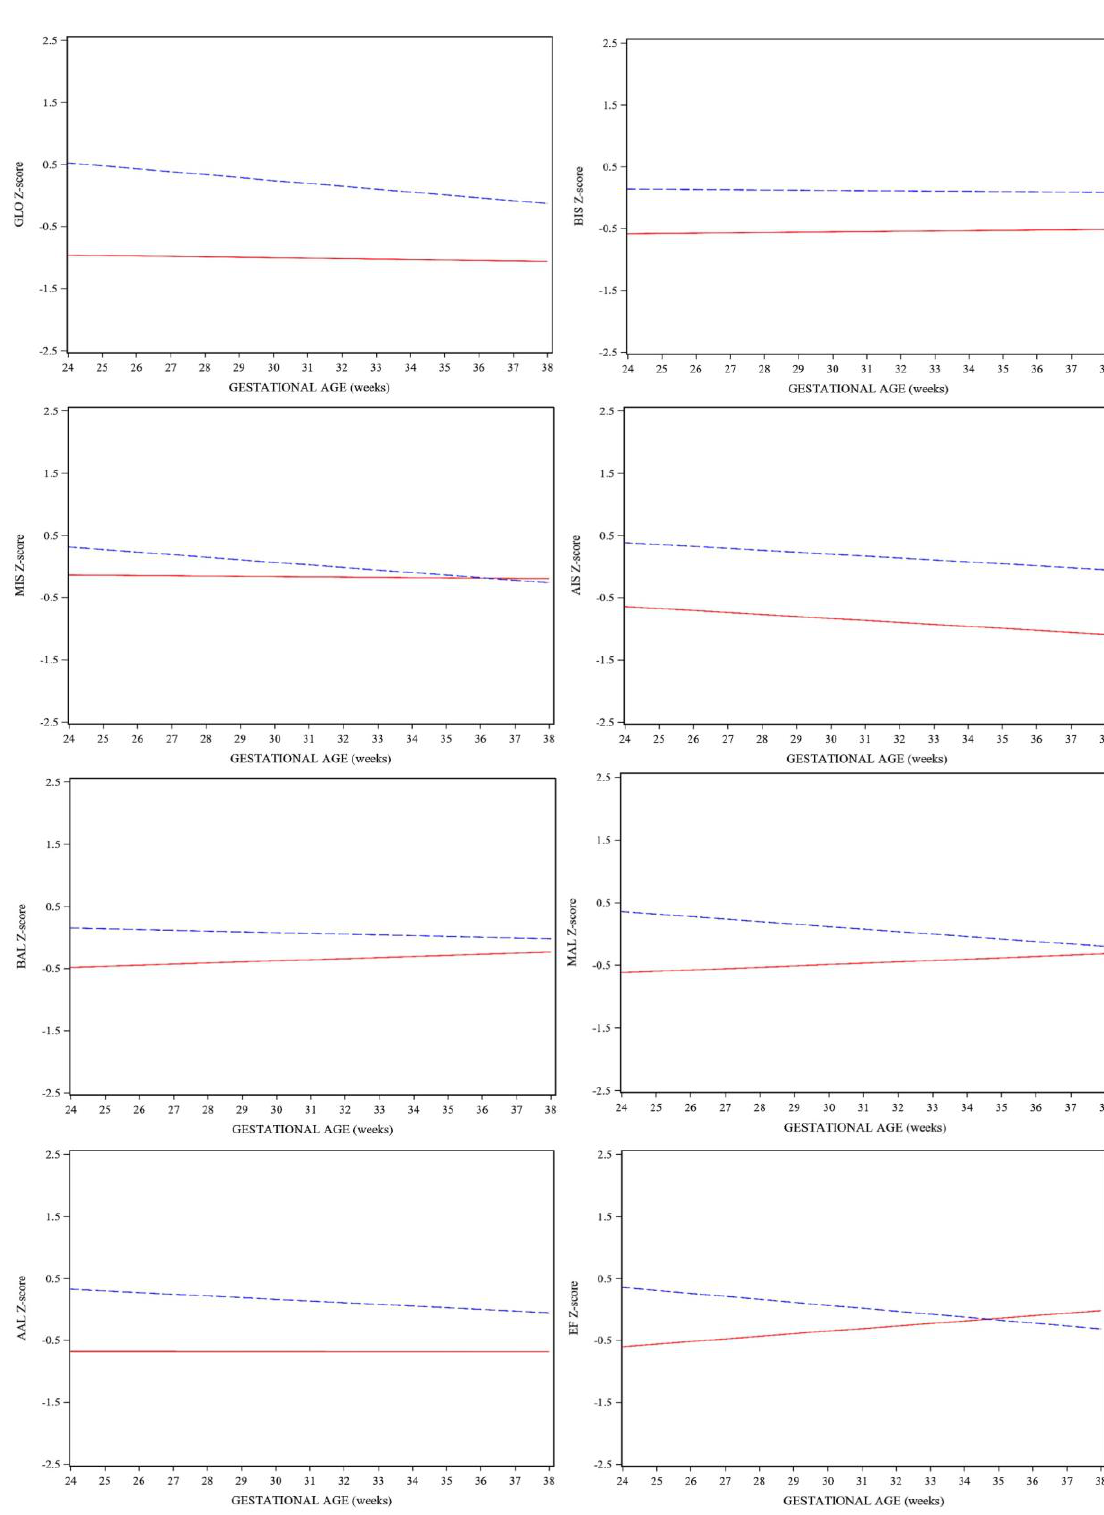
Figure 2. Longitudinal behavior of strain parameters in FGR fetuses (red continuous line) compared to AGA fetuses (blue interrupted line). GLO, global longitudinal strain; BIS, basal interventricular septum; MIS, middle interventricular septum; AIS apical interventricular septum; BAL, basal segment of left-ventricle wall; MAL, middle segment of left-ventricle wall; AAL, apical segment of left-ventricle wall; EF, ejection fraction.